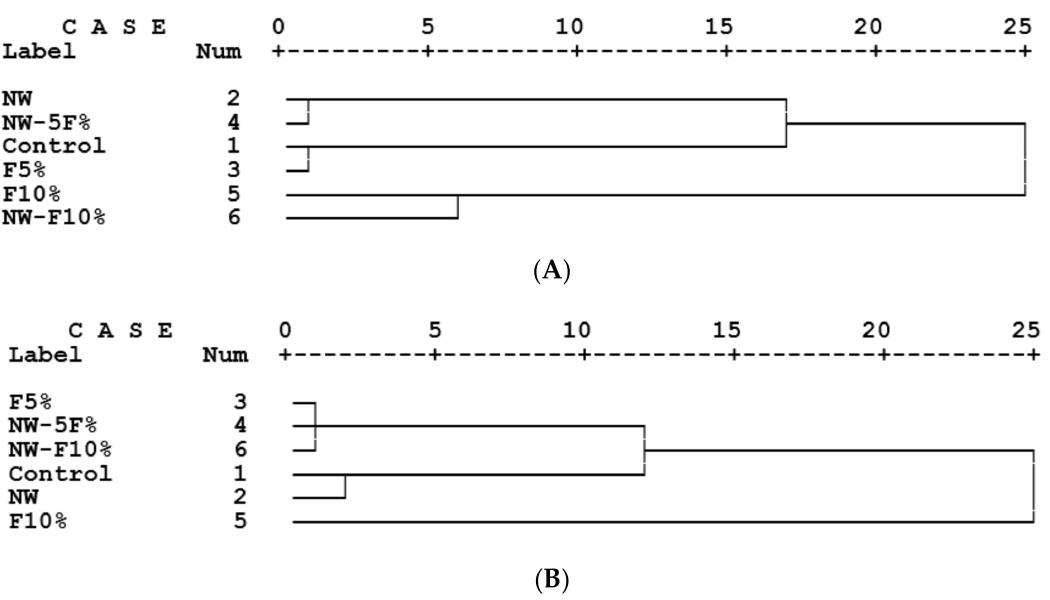
Figure 4. Cluster analysis in the medium-density fiberboard ( A ) and particleboard ( B ) panels based